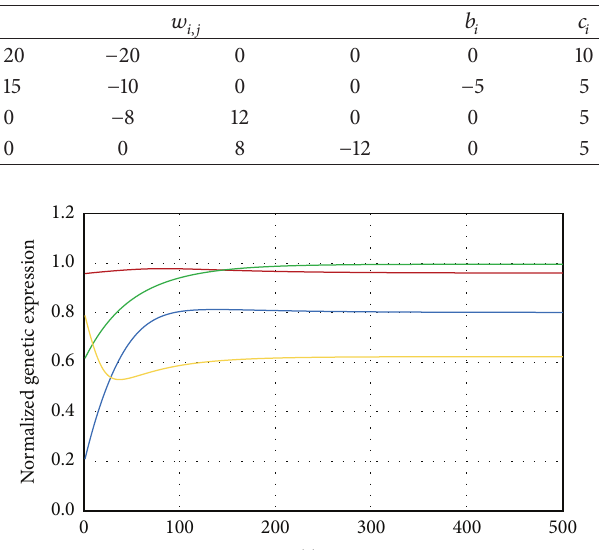
Table 1: RNN model parameters [32, 34].